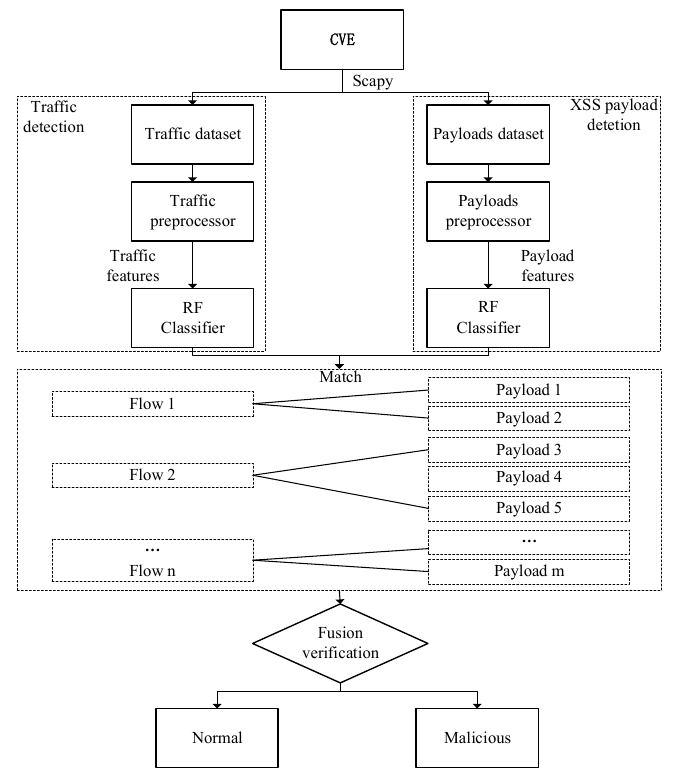
Figure 1. The framework of the proposed method.